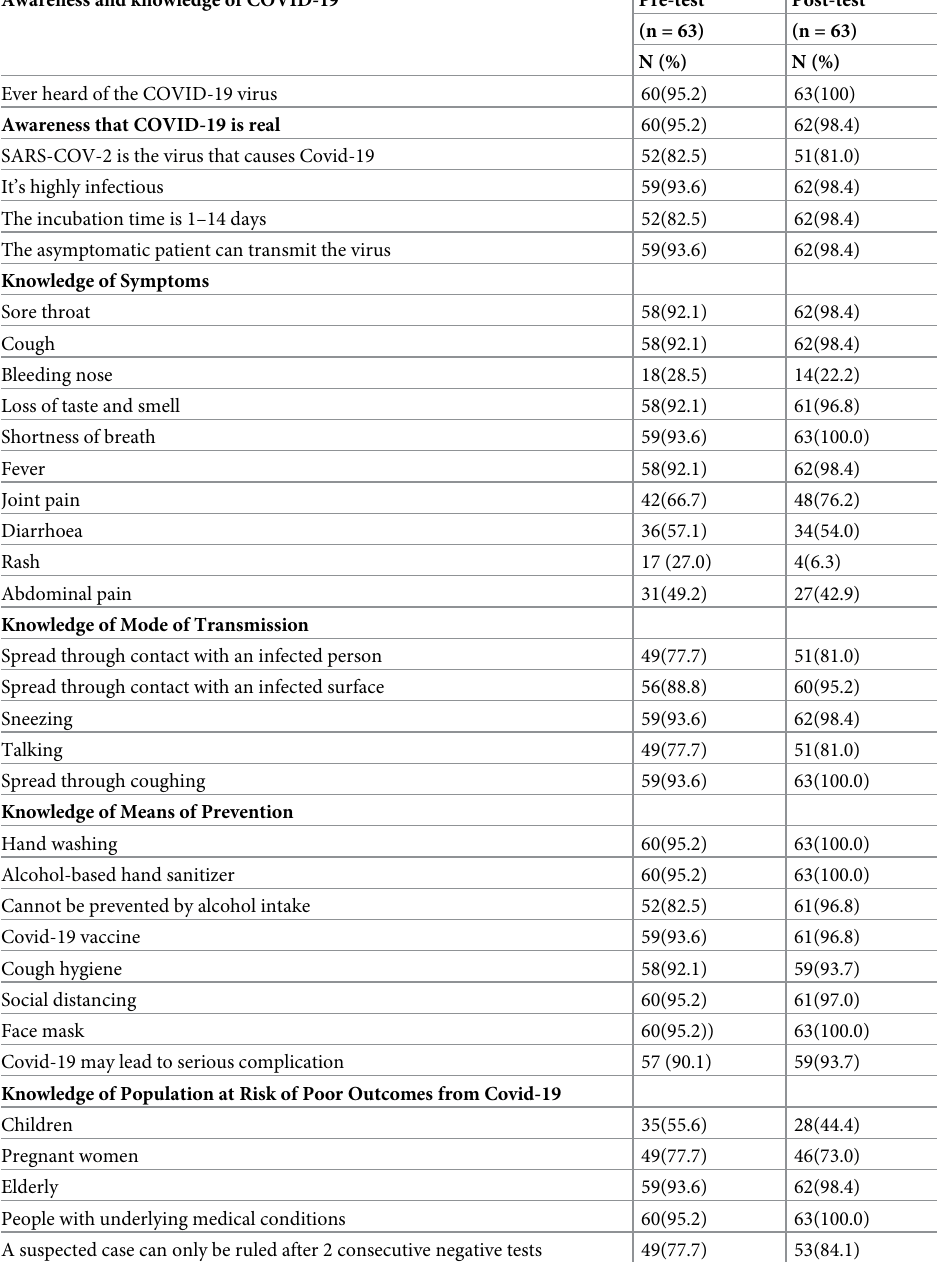
Table 2. Awareness and knowledge of COVID-19 among PHC workers pre-and post-training. Awareness and knowledge of